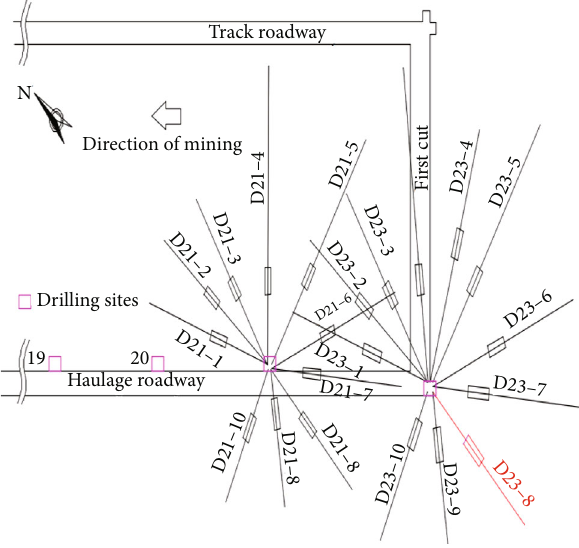
Figure 8: Sketch map of boreholes during grouting engineering.